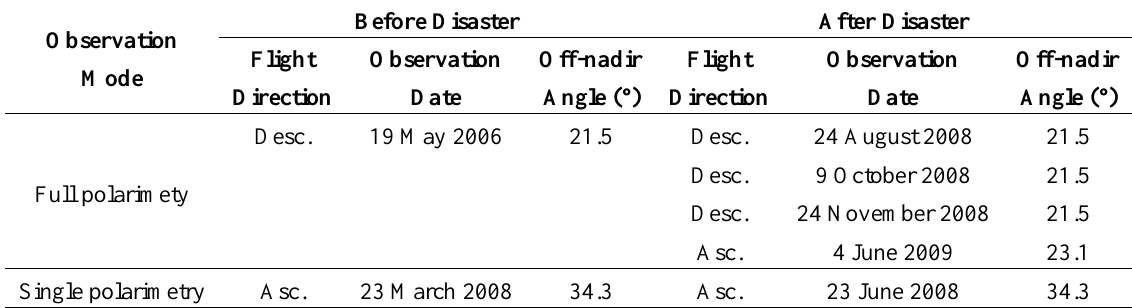
Table 1. Summary of Observation Mode for PALSAR (Phased Array type L-band Synthetic Aperture Radar)